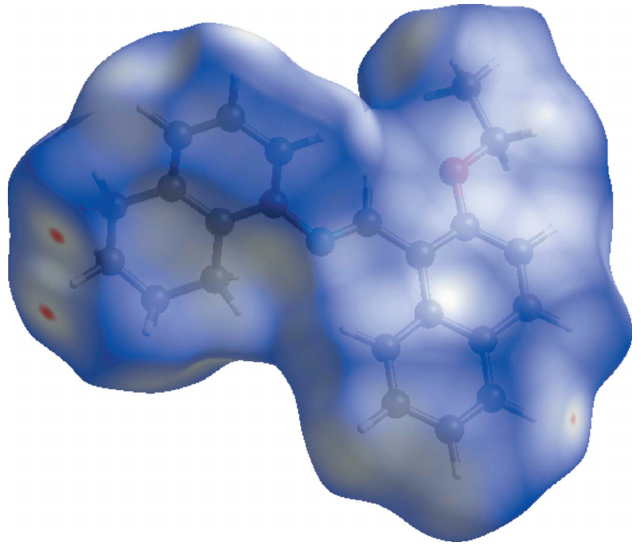
Figure 3 The Hirshfeld surface of the title compound mapped over d norm